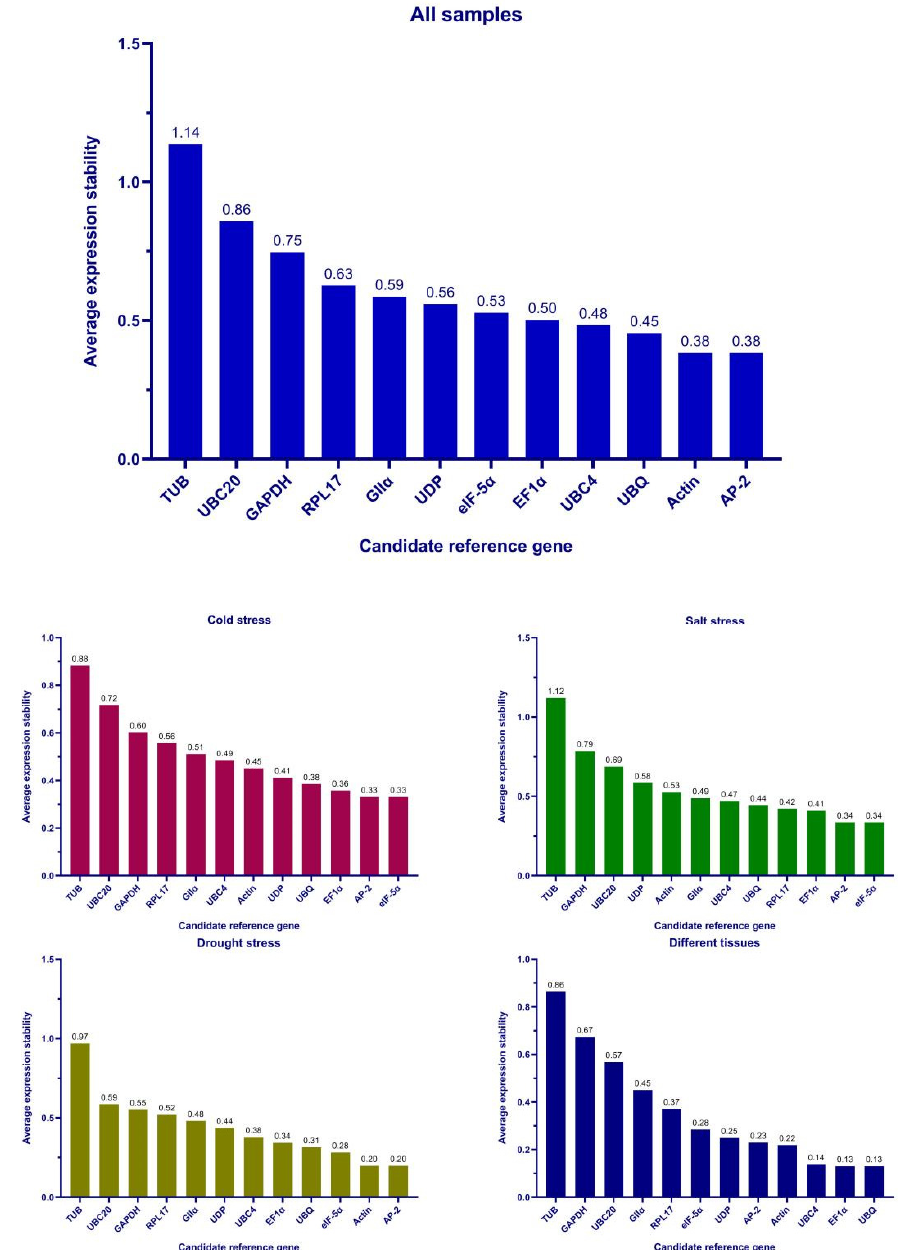
Figure 3. Expression stability of twelve reference genes under different conditions based on a geNorm analysis.